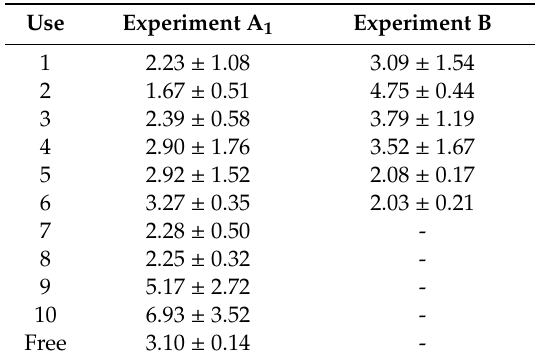
Table 2. Ethanol (g/L) produced by S. cerevisiae W13 loaded on apple pieces after 24 h of fermentation. Mean values ± standard deviation.